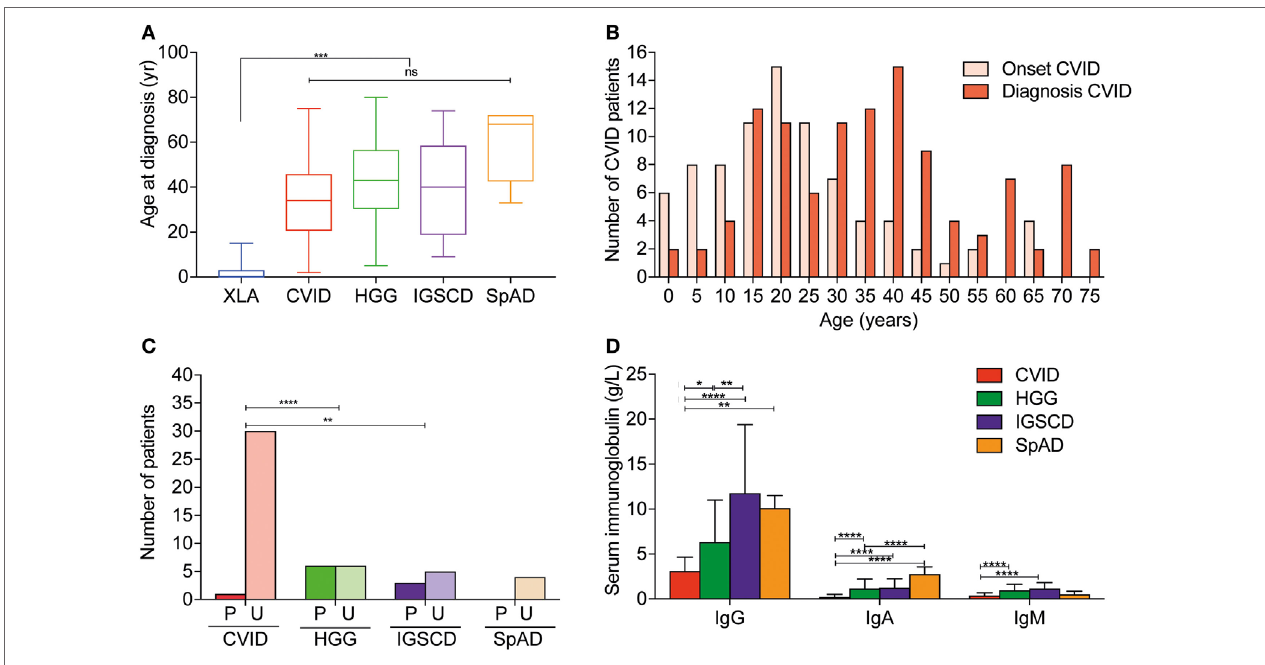
FigUre 1 | Age at diagnosis and diagnostic features differ between disease groups in Victorian adult patients with predominantly antibody deficiencies. (a) Box–whisker plot of age at diagnosis according to disease classification with median and 5–95% percentiles indicated. (B) Histogram demonstrating age at reported symptom onset, light red, and age at diagnosis (dark red) in common variable immunodeficiency (CVID) patients. (c) Qualitative vaccine responses to pneumococcal polysaccharide vaccine responses measured IgG binding against PPS23 polysaccharides in CVID patients (red), unclassified hypogammaglobulinemia (HGG) patients (green), IgG subclass deficiency (IGSCD) (purple), and specific antibody deficiency (SpAD) (orange). Darker colored columns indicate protective responses, P, and lighter colored columns indicate unprotective responses, U ( χ 2 analysis: ** p < 0.01 and **** p < 0.0001). (D) Serum IgG and IgA (g/L, mean ± SD) at diagnosis according to disease classification (** p < 0.01, *** p < 0.001, and **** p < 0.0001, using one-way